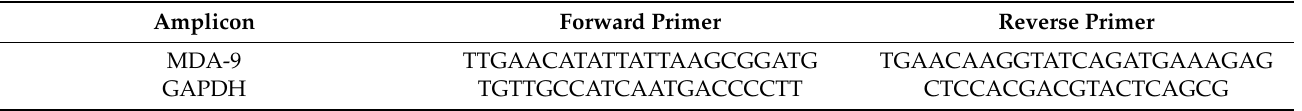
Table 1. Primers used on this